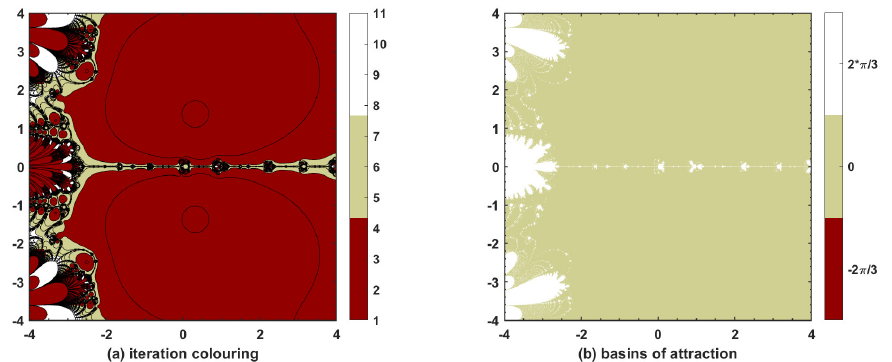
Figure 6. The basins of attractions by the proposed method PM 10 for P 4 ( z ) .